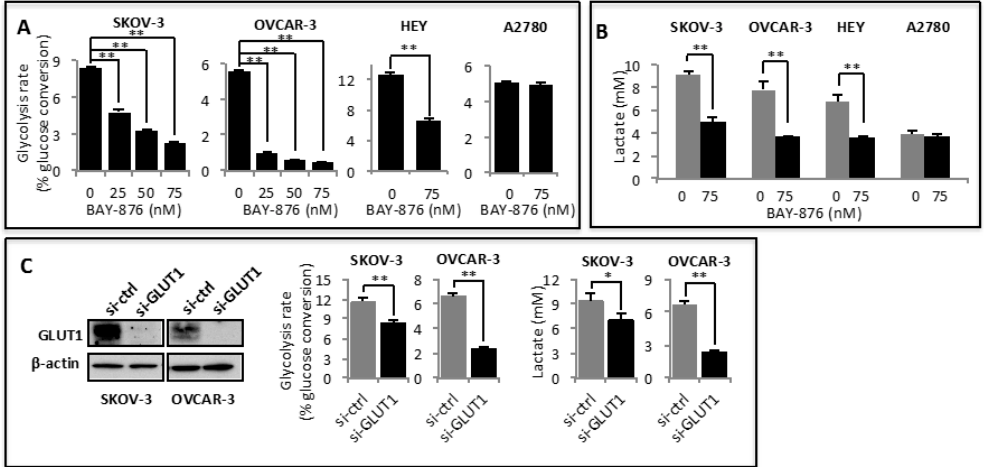
Figure 1. Glucose transporter 1 (GLUT1) activity is required for maintenance of hyperactive glycolysis in ovarian cancer. Ovarian cancer cell lines were treated for 24 h with indicated concentrations of BAY-876. The glycolytic rate ( A ) and lactate concentrations in supernatants ( B ) were measured as described in Materials and Methods. The lactate levels are presented as mM concentrations present in 1 mL culture supernatants normalized to 5 × 10 5 cells over 24 h incubation. In ( C ) GLUT1 was silenced by siRNA in SKOV-3 and OVCAR-3 cells and effects of siRNA knockdown on glycolysis and lactate production were determined. For this and all the following figures, the data presented were mean ± SD of triplicates, representative of 3 independent experiments unless otherwise indicated. * p